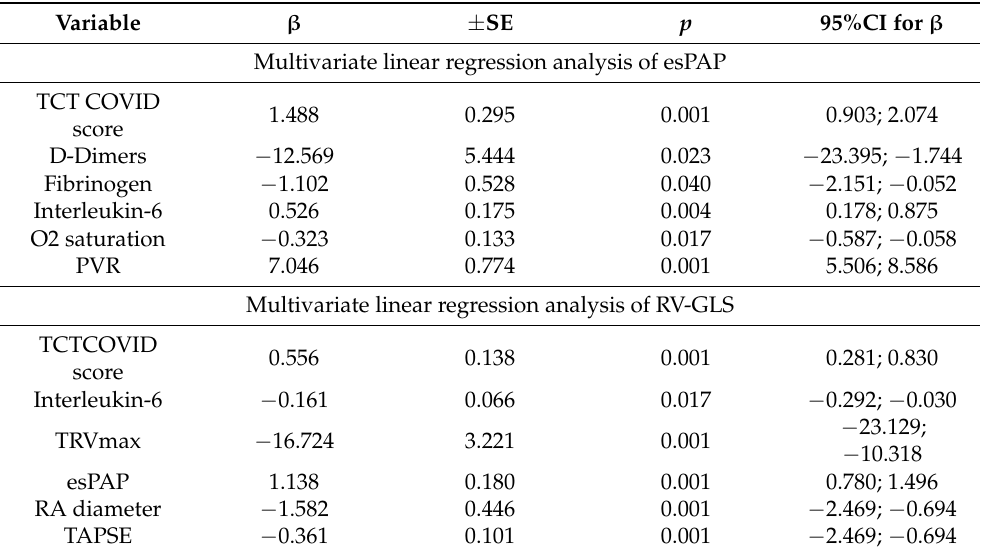
Table 3. Multivariate linear regression